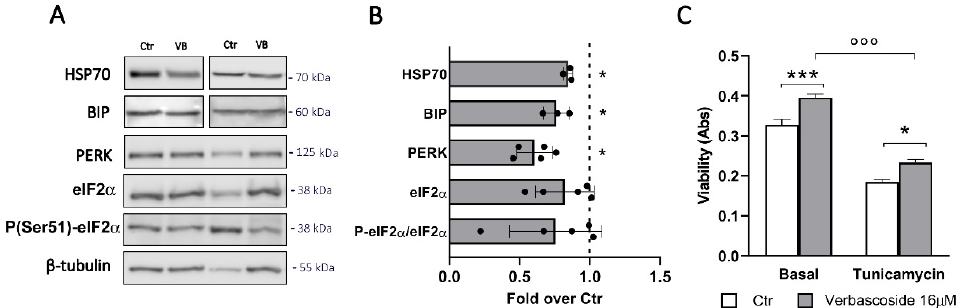
Figure 3. Verbascoside reduces ER stress. ( A ) Western blot analysis of ER stress markers in cells treated with 16 µ M verbascoside (VB) for 5 days (30 µ g protein / sample). On the right, the molecular-weight size markers in kDa are reported. ( B ) The quantitative analysis shows that verbascoside treatment reduces the expression of HSP70, BIP and PERK proteins. Data (mean values ± SD) are expressed as fold change over control (dashed line). (n = 3–5 independent experiments performed in triplicate) (Student’s t-test * p < 0.05 vs. Ctr). ( C ) Mouse β tc3 cells were incubated with 16 µ M verbascoside